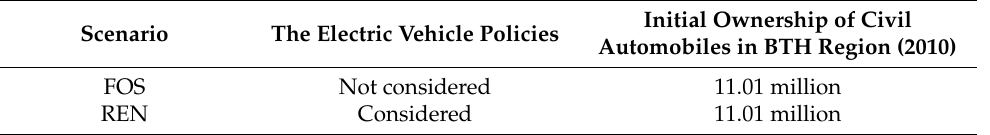
Table 1. Scenarios setting.